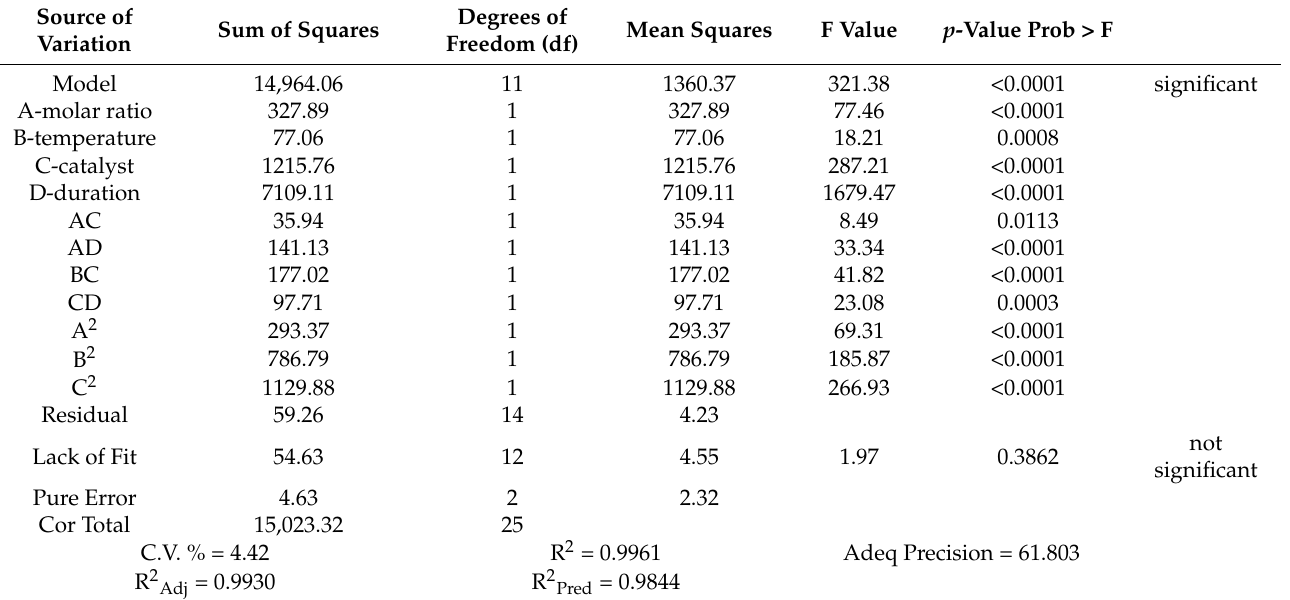
Table 4. Analysis of variance of quadratic model (ANOVA).